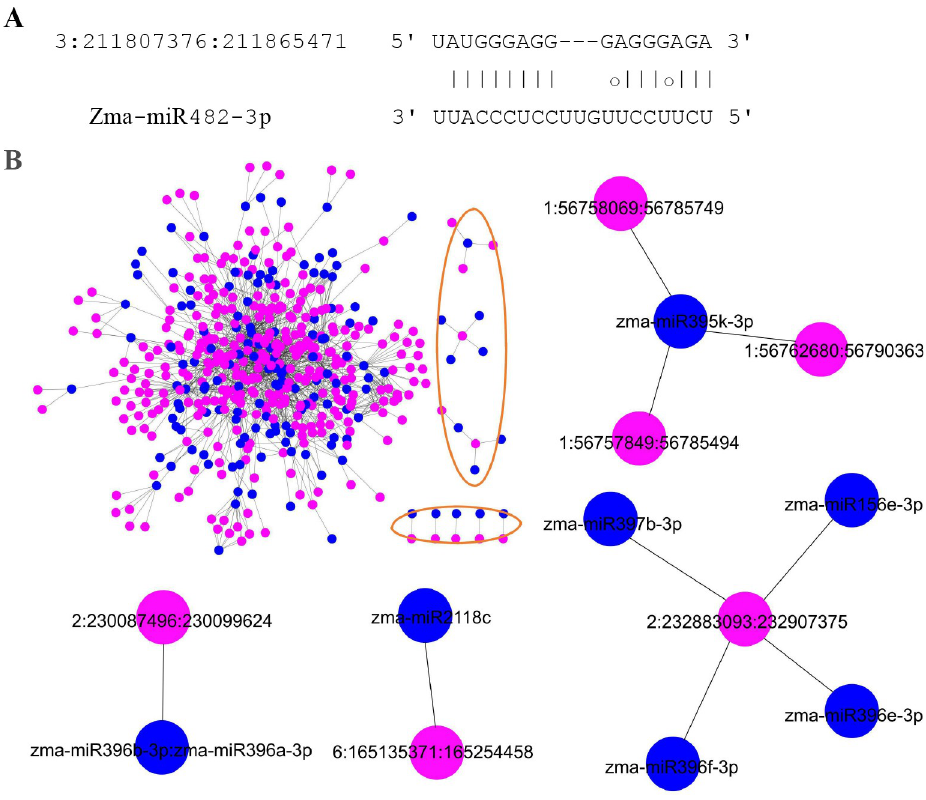
Fig 5. circRNAs acting as miRNA decoys. (A) Binding sites between a circRNA and the corresponding miRNA. (B) The circRNA-miRNA regulatory network. The single network was marked by orange circle. Representative single network were extracted from the integral network. Pink nodes represent circRNAs and blue nodes represent miRNAs. The edges represent connected nodes that exist as a correlation.